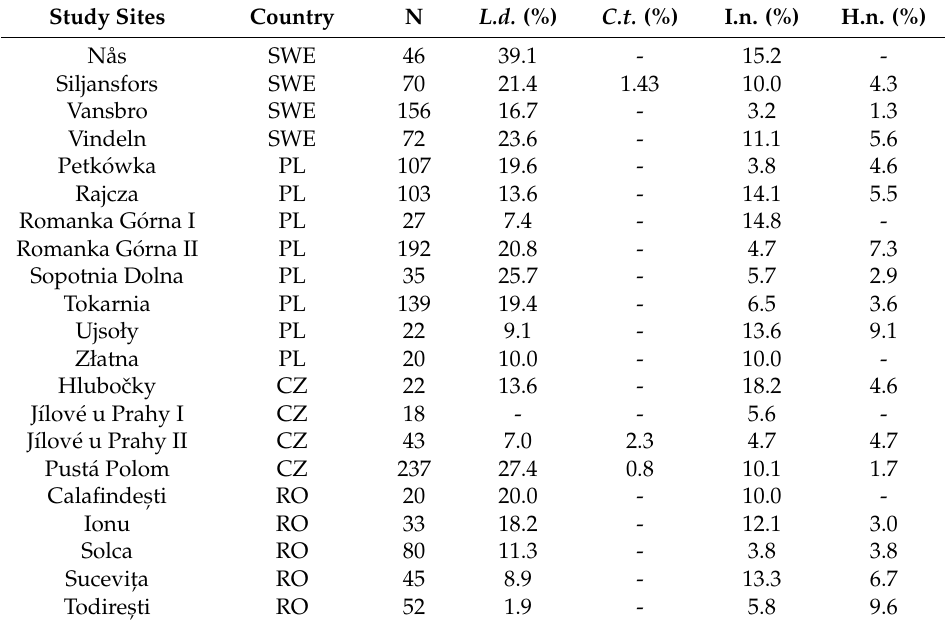
Table 2. Infection levels of four pathogens in I. duplicatus . Infection level refers to the percentage of beetles with the indicated pathogen. The location of the study site (Country): Sweden (SWE), Poland (PL), Czech Republic (CZ), Romania (RO). For each study site there is a number of inspected beetles (N) and infection levels of: Larssoniella duplicati ( L.d. ), Chytridiopsis typographi ( C.t. ), parasitism by intestinal nematodes (I.n.) and hemolymph nematodes (H.n.).